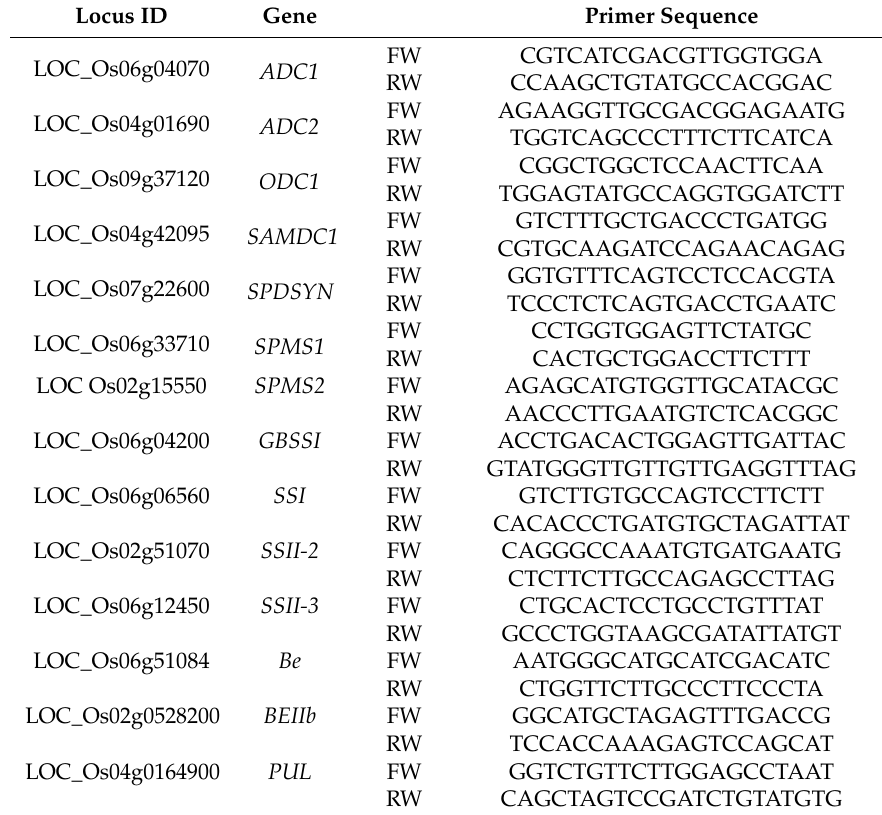
Table 3. Primer sequences used in RT-PCR (Real-time fluorescence quantitative polymerase chain